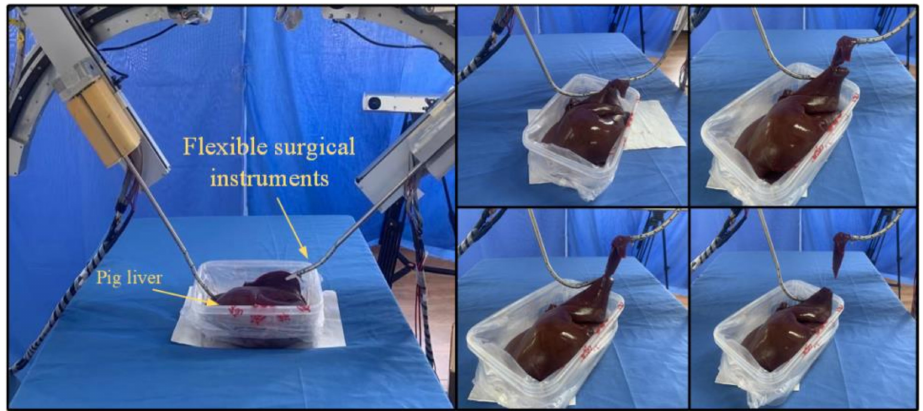
Figure 14. Pig liver tissue stripping and extraction